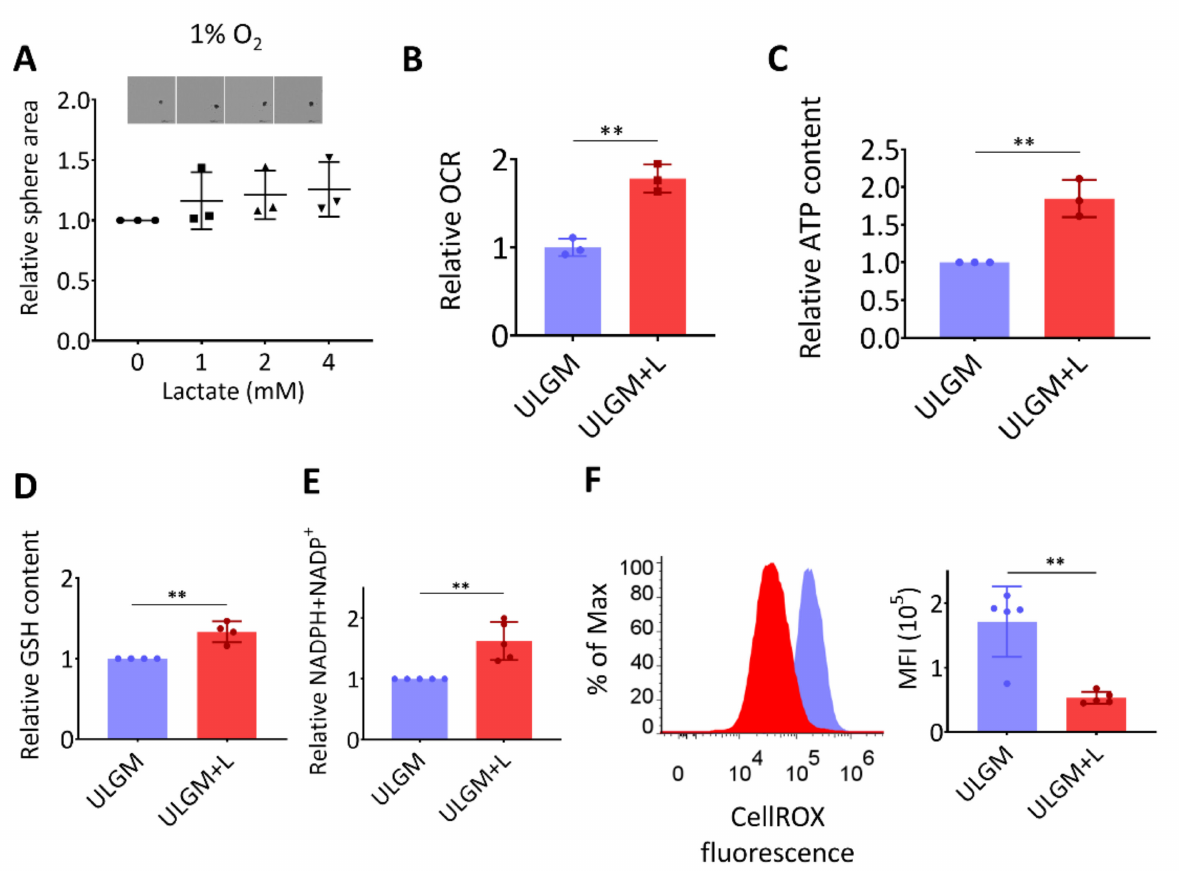
Figure 3. Lactate supports energy production and modulates redox balance in glucose-deprived GSCs. ( A ) Relative sphere growth for GSC mit (GSCB) cells cultured for 7 days under hypoxic conditions (1% O 2 ) in ULGM supplemented with the indicated concentrations of lactate. Representative images of the spheres formed in each condition are also presented. Scale bars, 500 µ m. ( B – F ) Relative oxygen consumption rate (OCR) ( B ), intracellular ATP content ( C ), glutathione (GSH) content ( D ), and total NADPH plus NADP + content ( E ) as well as representative plots and mean fluorescence intensity (MFI) of CellROX ( F ) for TSH-N5 cells cultured in ULGM or ULGM supplemented with 4 mM lactate (ULGM+L). All data are means ± SD from three to five independent experiments and were analyzed by one-way ANOVA followed by Dunnett’s post hoc test ( A ) or with the unpaired two-tailed Student’s t test (B–F). ** p <